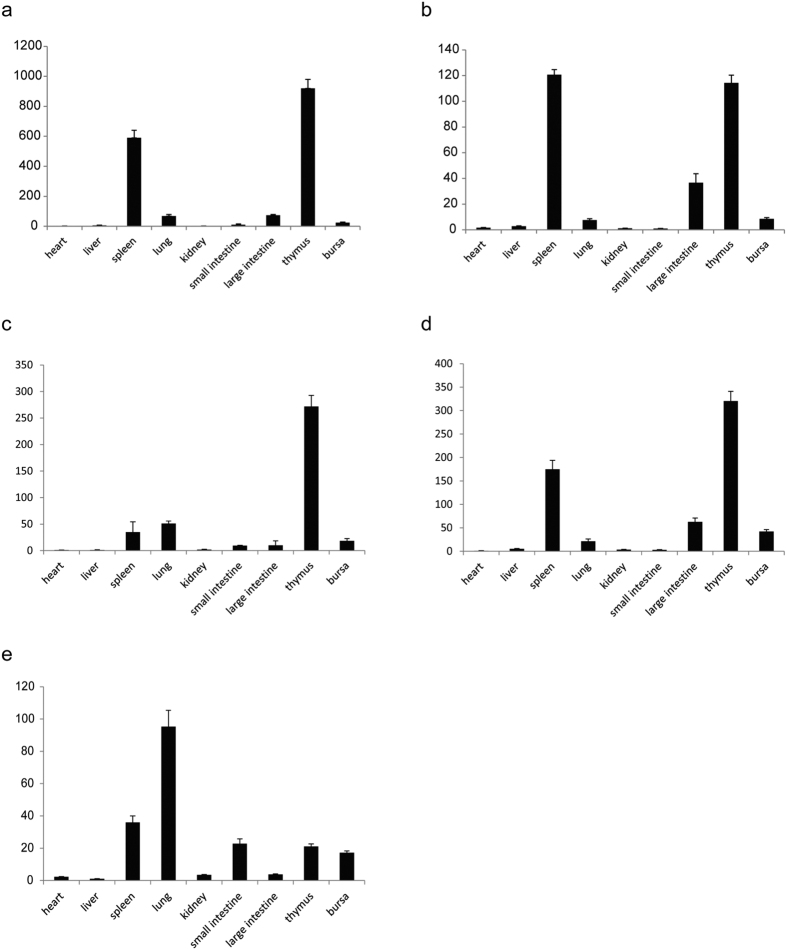
Quantitative real-time PCR analyses of the relative expression levels of duck TCR genes in different tissues, TCRα (a), TCRδ (b), TCRβ (c), TCRγ (d), and TCRδ2 (e). The duck EF1A1 gene was chosen as an internal control. The y-axis shows the normalized fold changes in expression, and the nine tissues are listed below the x-axis.